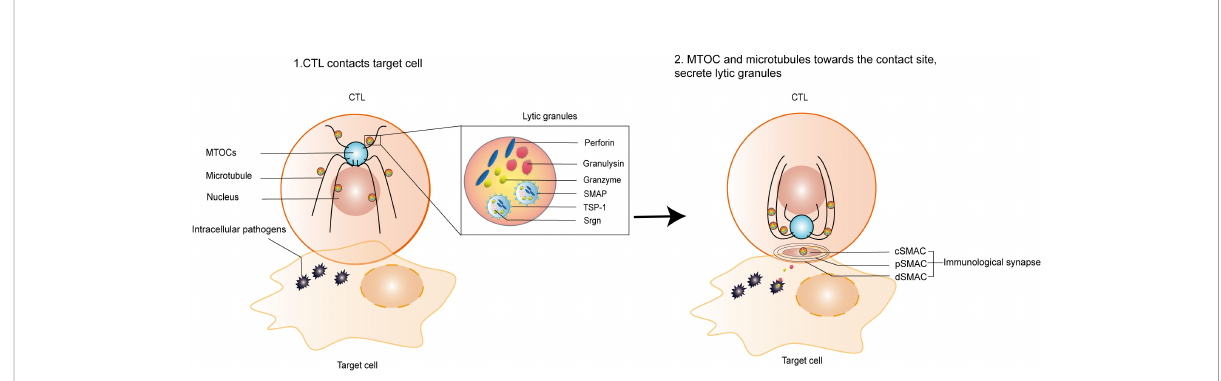
FIGURE 2 Formation of lytic IS and release of lytic granules. 1. CTLs contact infected target cells; 2. Formation of a lytic IS between CTLs and infected target cells, orienting the MTOC and the entire MTs network towards the contact sites where the lytic IS is being organized. Lytic granules, such as PFN, Gzm, GNLY, and SMAP, are released onto the surface of target cells or into target cells to kill intracellular bacteria. IS is composed of central supramolecular activation clusters (cSMACs), peripheral supramolecular activation clusters (pSMACs), and distal supramolecular activation clusters (dSMACs). SMAP includes a glycoprotein shell named TSP-1 and a core containing PFN, GzmB and Srgn cytotoxic proteins. IS, immunological synapse; MTOCs, microtubule organizing centers; MTs,